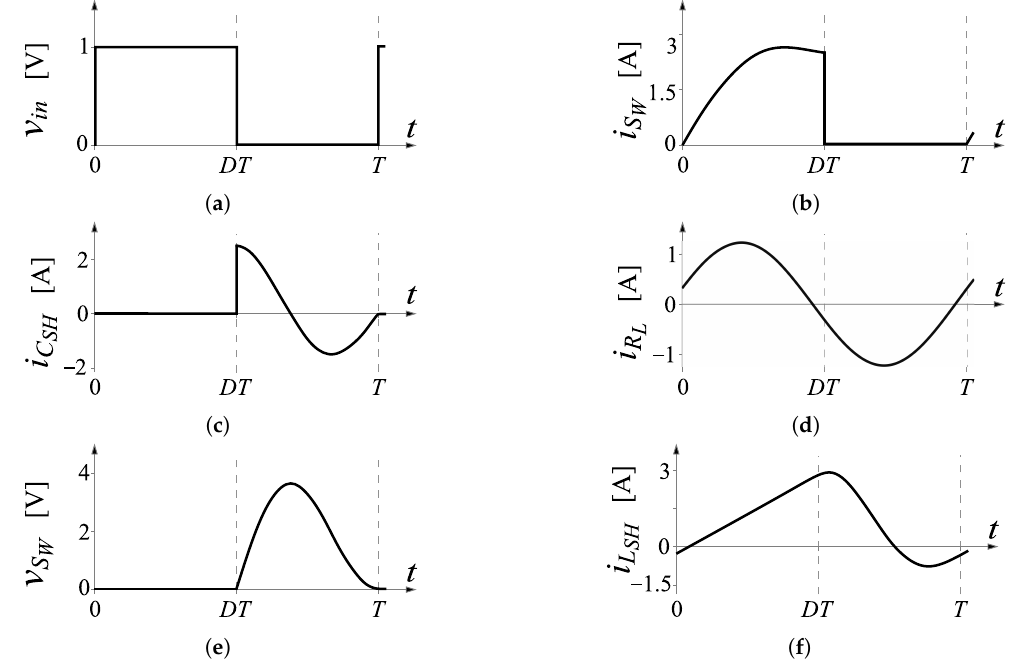
Figure 2. Class-E PA ideal waveforms for duty cycle = 0.5, V DD = 1 V, and output power = 1 W. ( a ) v in